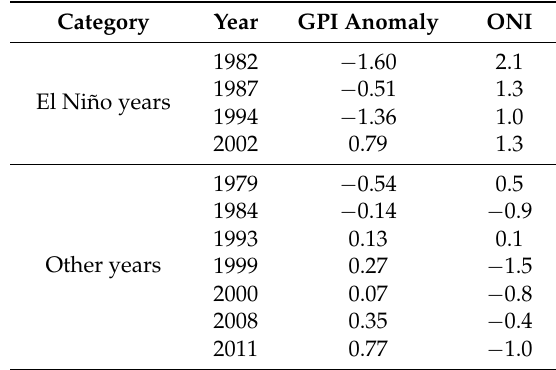
Table 4. The averaged GPI anomaly for the SEI region and the averaged ONI during OND for the MJO active years, divided into the El Niño years and the other